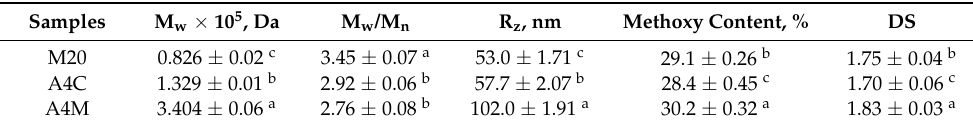
Table 1. The weight average molar mass (M w ), polydispersity index (M w /M n ), radius of gyration (R z ), methoxy content, and DS of